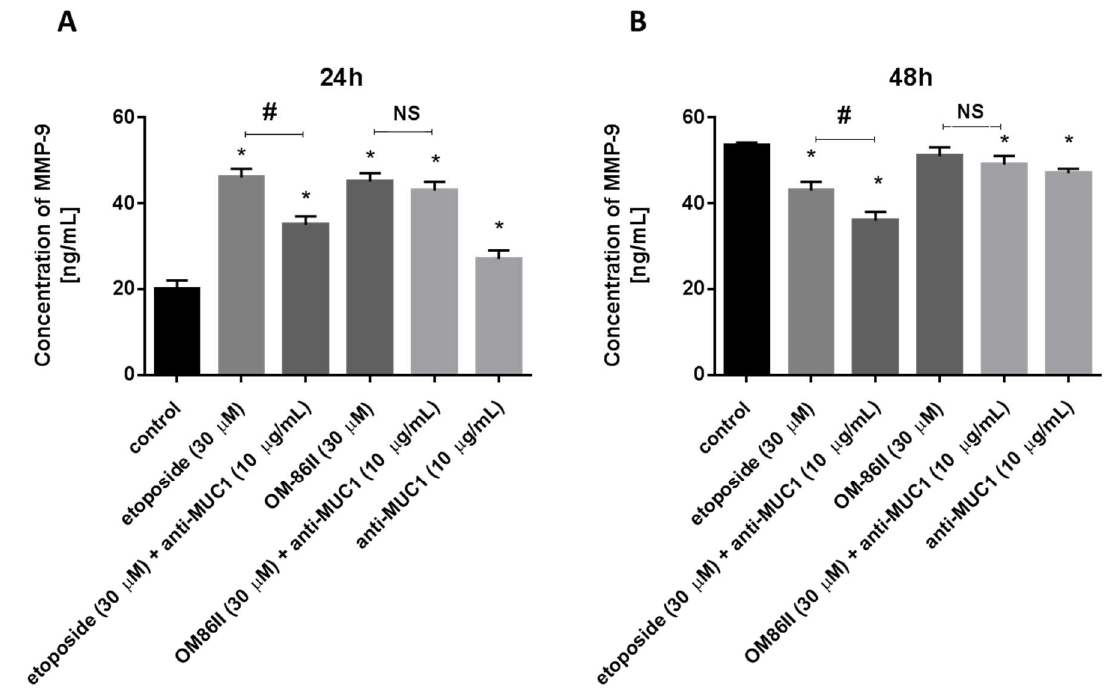
Figure 10. The concentration of MMP-9 in human gastric cancer AGS cells after 24 h ( A ) and 48 h ( B ) of incubation with anti-MUC1 (10 µg/mL), OM-86II (30 µM), OM-86II + anti-MUC1 (30 µM + 10 µg/mL), etoposide (30 µM) and etoposide + anti-MUC1 (30 µM + 10 µg/mL). Data are presented in ng/mL. * p < 0.05 vs. control group; # p < 0.05. MUC1, mucin-1; OM-86II, octahydropyrazin[2,1-a:5,4-a′]diisoquinoline derivative; ns, not significant.